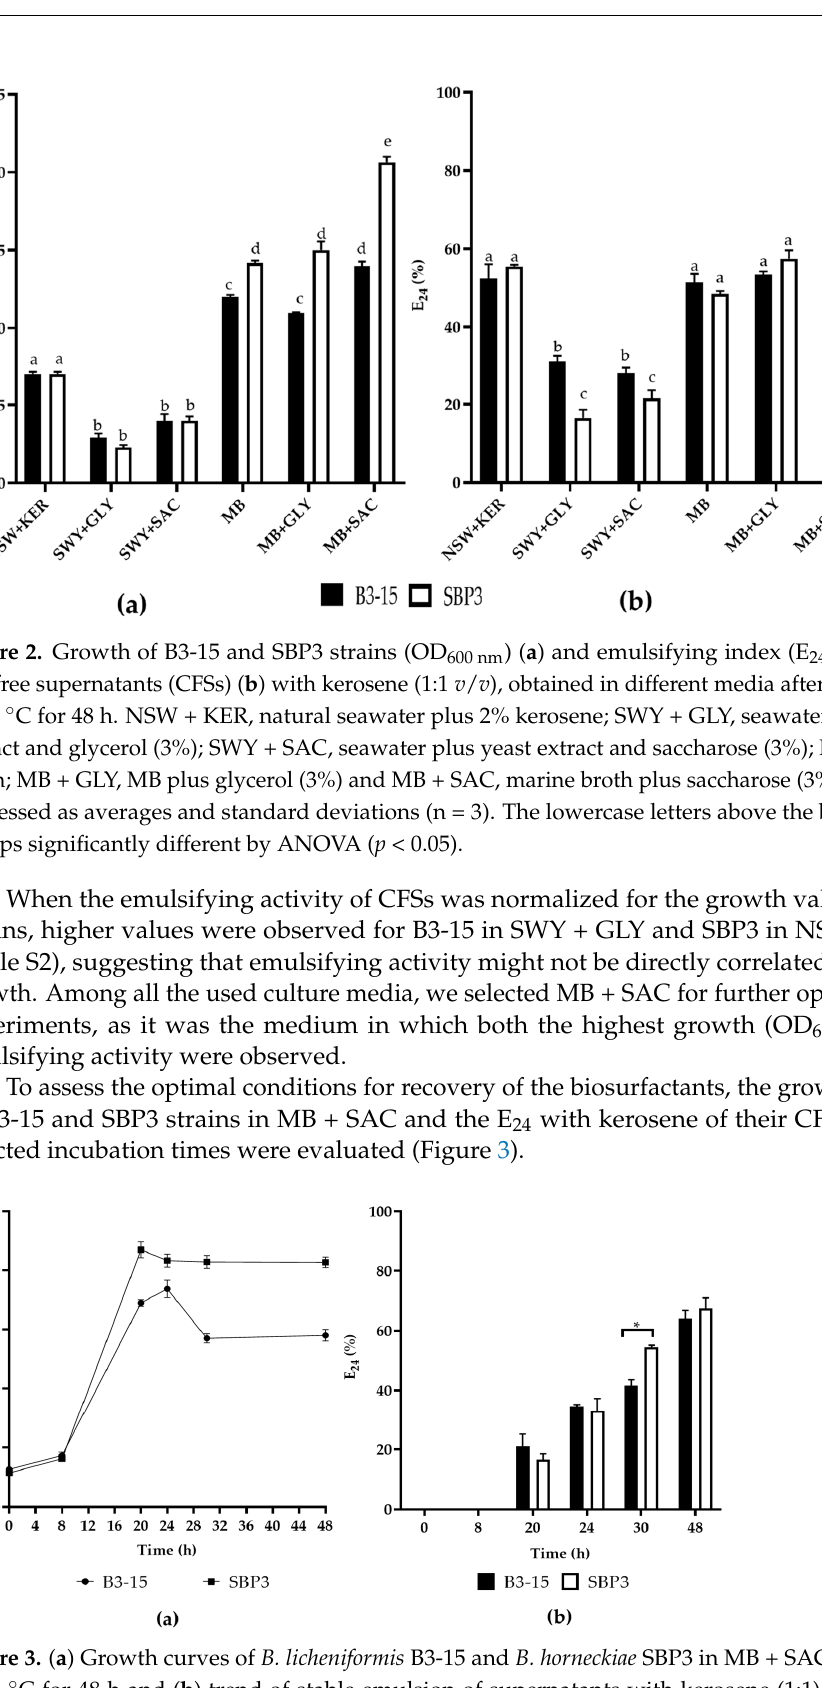
Figure 3. ( a ) Growth curves of B. licheniformis B3-15 and B. horneckiae SBP3 in MB + SAC incubated at 45 °C for 48 h and ( b ) trend of stable emulsion of supernatants with kerosene (1:1) during the fermentation. Data are expressed as averages and standard deviations (n = 3). * Significantly different ( p < 0.05). SBP3 strain grew better than B3-15, reaching the maximal growth (OD 600 nm = 2.1) after 20 h of incubation (Figure 3a). The E 24 increased during the selected incubation period and